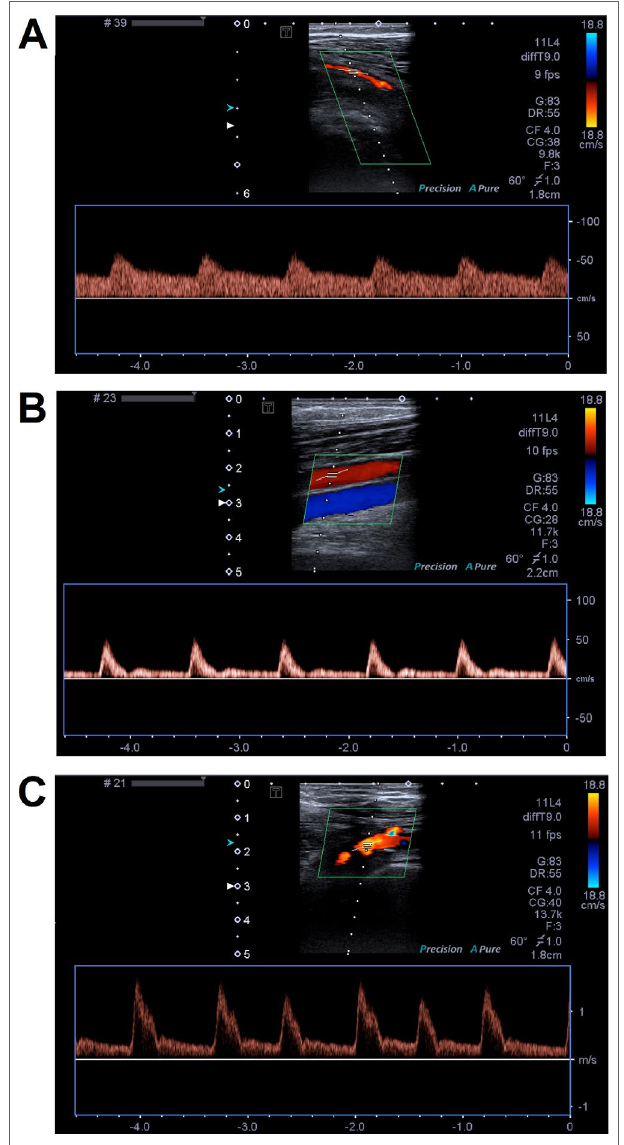
FigURE 1 | Representative color Doppler images of femoral arteries. Panels (A) and (B) present femoral artery narrow stenosis caused by atheromatic plaque without calcification. Arterial flow has monophasic waveform with low systolic peaks and continuous diastolic flow. On panel (B) , popliteal artery blood flow restored femoral artery flow by inflow from collaterals. On panel (c) , femoral artery occlusion and monophasic waveform of flow with high systolic peaks and continuous diastolic flow were observed.